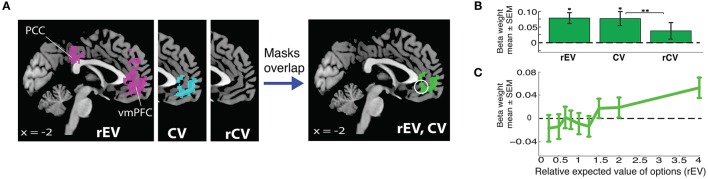
Neural encoding of value signals for gains. (A) Whole brain analyses localizing value signals with three different value regressors (relative expected value, rEV; chosen value, CV; relative chosen value, rCV). The white circle indicates the unbiased 10 mm spherical vmPFC ROI (x = −2, y = 40, z = −8). (B) vmPFC ROI analyses demonstrate the strength of the encoding for each of the three tested formulations of trial value (*significantly different from 0; **significantly different from each other). (C) Extracted functional relationship between vmPFC activation and each gain rEV category, extracted from the vmPFC ROI.